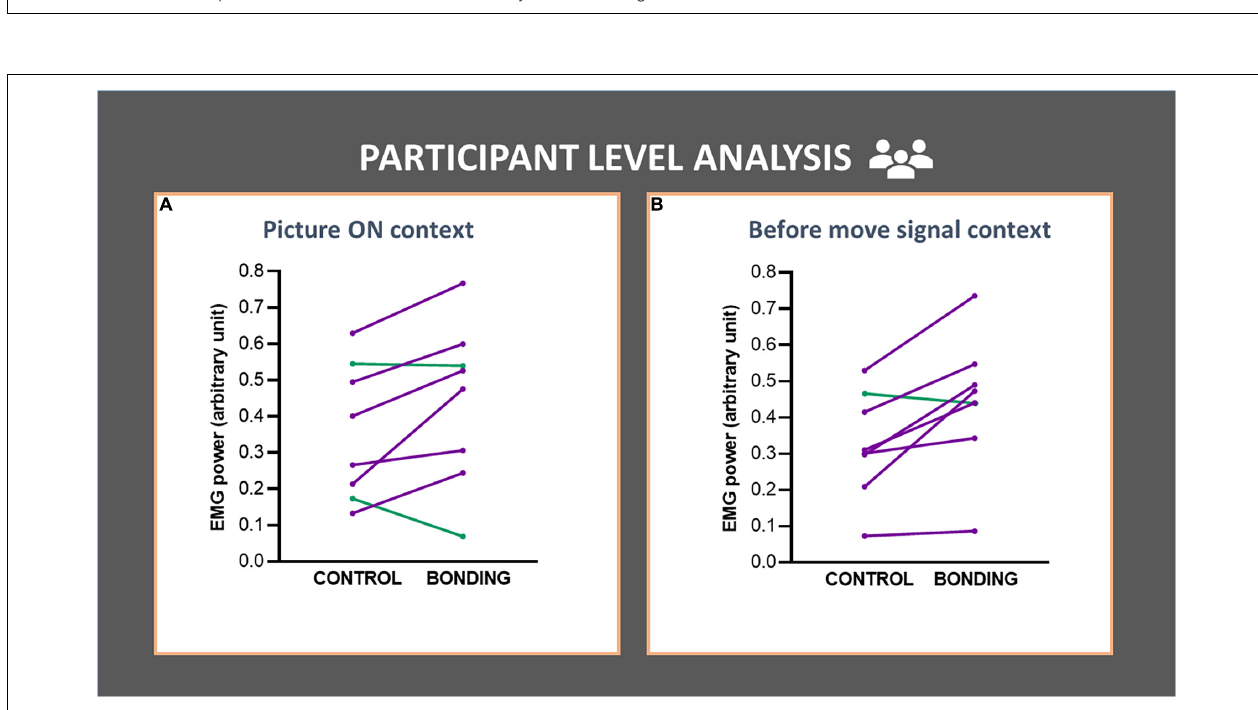
FIGURE 4 | Participant-level analysis in each context (A,B) of the finger flexor muscle EMG activity. Each line represents data for a participant (averaged from all trials). EMG activity of the finger flexor muscle is depicted in the bonding and control conditions. (A) Picture ON context and (B) before move signal context. The lines joining control and bonding conditions represent normalized EMG power for each participant, averaged from all trials. Purple lines represent data for participants with increased values in bonding relative to the control conditions and green lines represent the